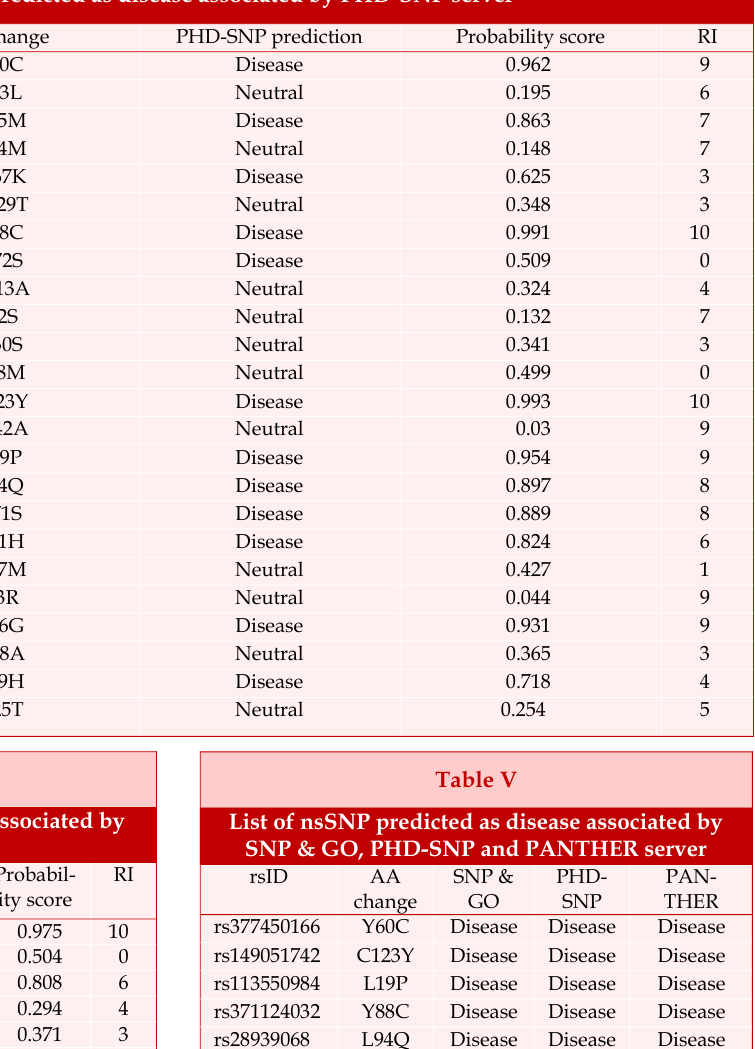
List of nsSNP predicted as disease associated by SNP & GO, PHD-SNP and PANTHER server rsID PAN- THER rs377450166 Disease Disease Disease rs149051742 C123Y Disease Disease Disease rs113550984 Disease Disease Disease Disease Disease Disease